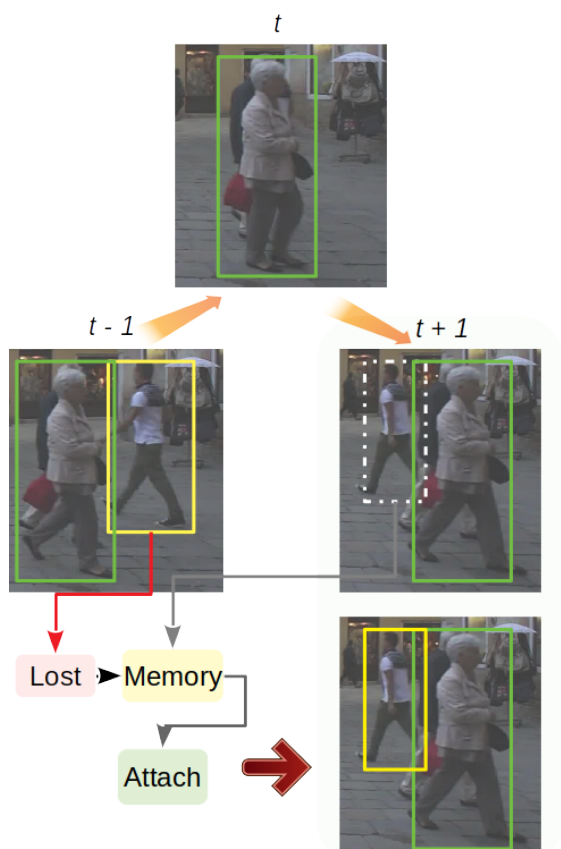
Figure 4. An example of how attaching handles object retrieval after occlusion. The occlusion happens at time t , the single object tracker belonging to the object in the yellow box at time t failed to track and save to memory. A new object in the white dotted box is initialized from detection at time t + 1 after occlusion. The attaching phase is able to attach the new object in the white dotted box to the lost one in the yellow box, eliminate the object in white dotted box, and keep tracking using the single object tracker from the yellow box object from